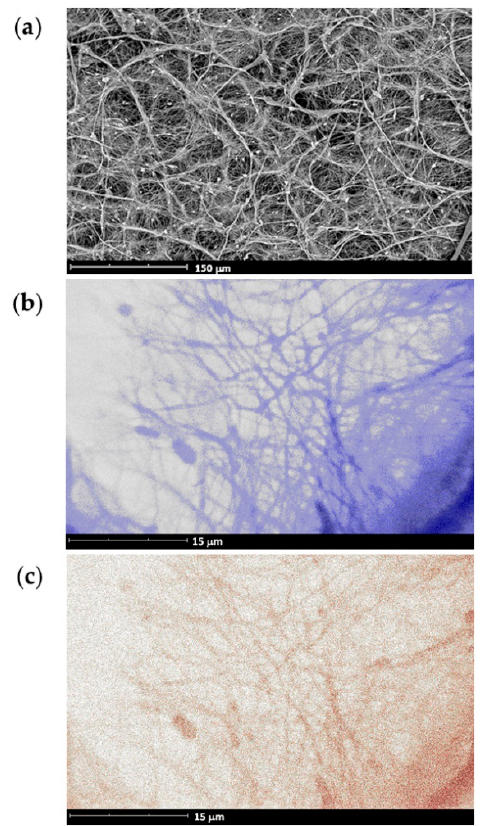
Figure 15. ( a ) SEM image of PCL/HAp composite ES fibers, prepared in the presence of 5% wt PCL- b -poly( t BuOEP); The distribution of ( b ) Ca and ( c ) N in ES fibrous film (SEM EDX mapping data). Reprinted with permission from [92]. Copyright (2021) MDPI.